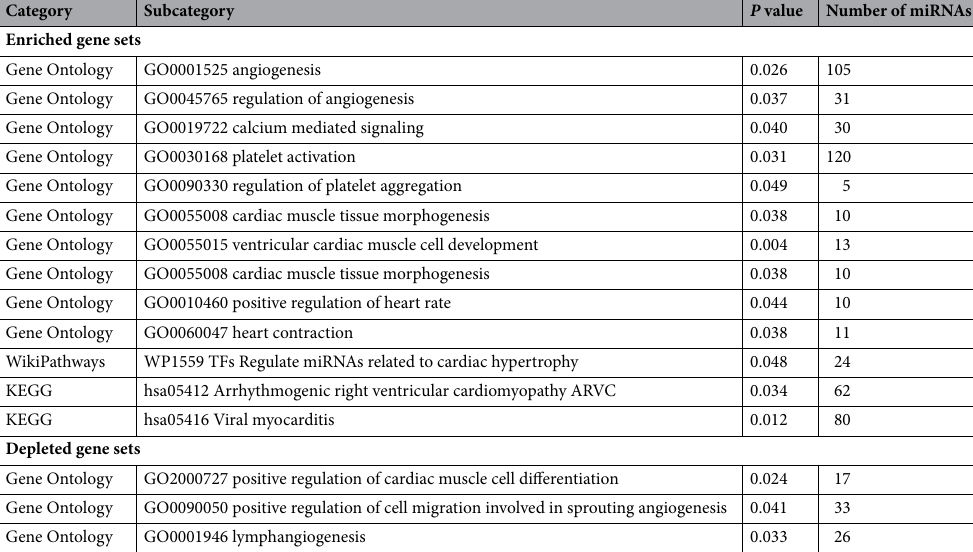
Table 7. Enriched and depleted gene sets associated with cardiac function, cardiovascular disease, and